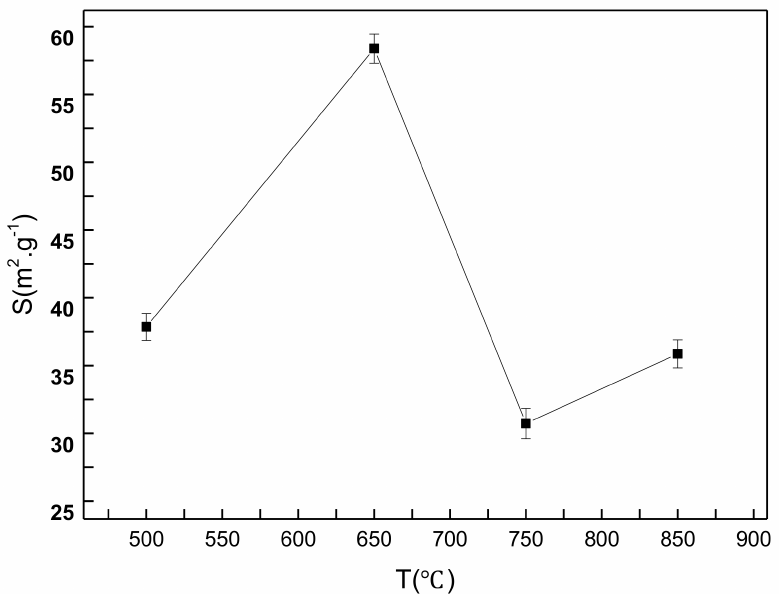
Figure 6. The specific surface area of the CeO 2 products prepared at various spray pyrolysis